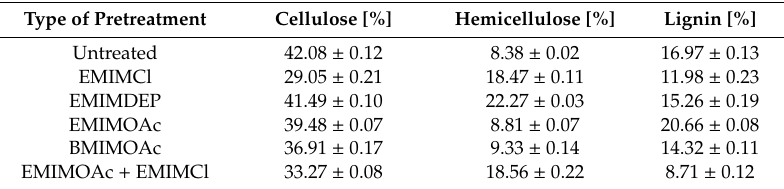
Table 1. Composition of buckwheat straw: untreated and after pretreatment ionic liquids. Type of